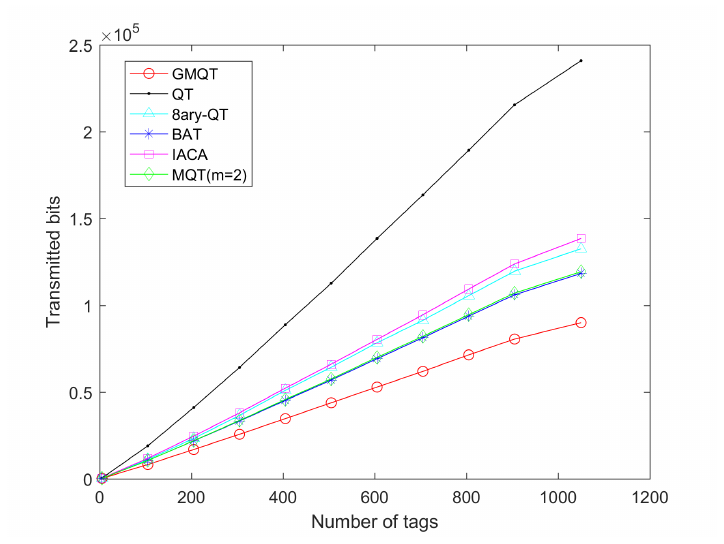
Figure 4. Communication complexity with different